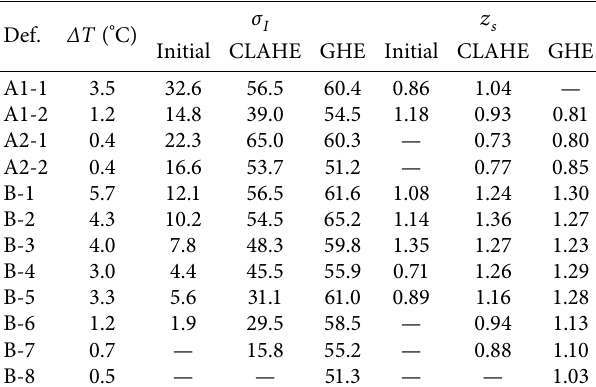
Table 3: Optimization parameters.